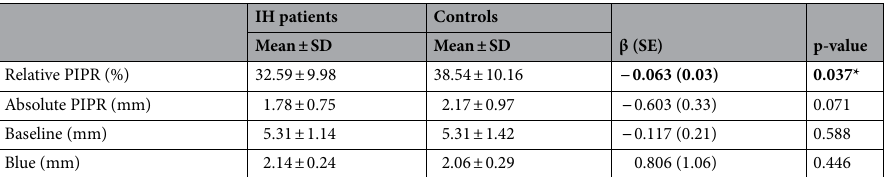
Table 3. Binomial logistic regressions between diagnostic group and pupillary response in 28 IH patients with Long Sleep Time and 29 Controls. The logistic regression compares each pupillometry parameter between groups (group as dependent factor, controls as reference category), with age included as covariate. Significant values are in [bold]. IH idiopathic hypersomnia patients with long sleep time, Controls healthy subjects, PIPR post-illumination pupil response, Baseline baseline pupil diameter, Blue pupil diameter during blue light exposure, β (SE) binomial logistic regression coefficient (Standard Error). Significant logistic regression between the markers: *significant difference between groups, p-value <